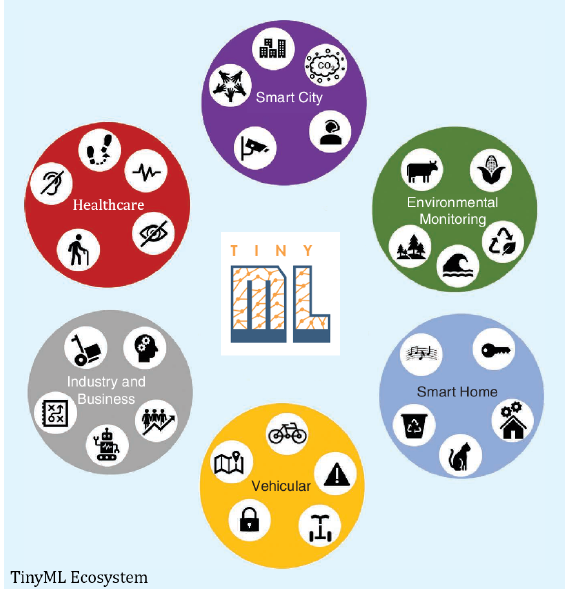
Figure 6. TinyML